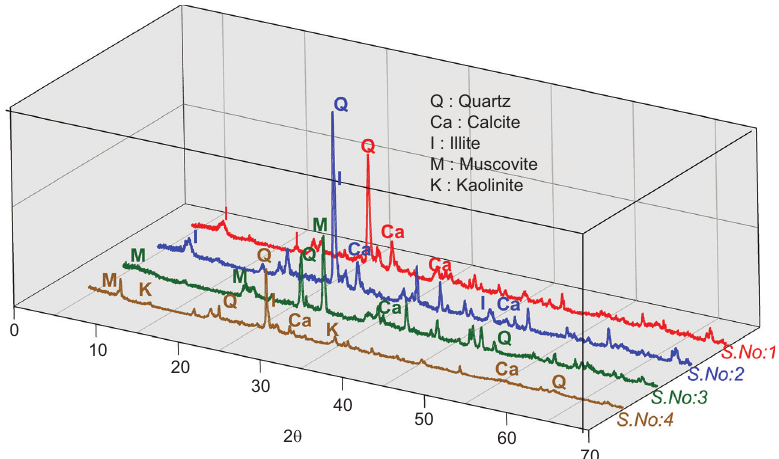
Figure 3 XRD patterns of the soil samples.